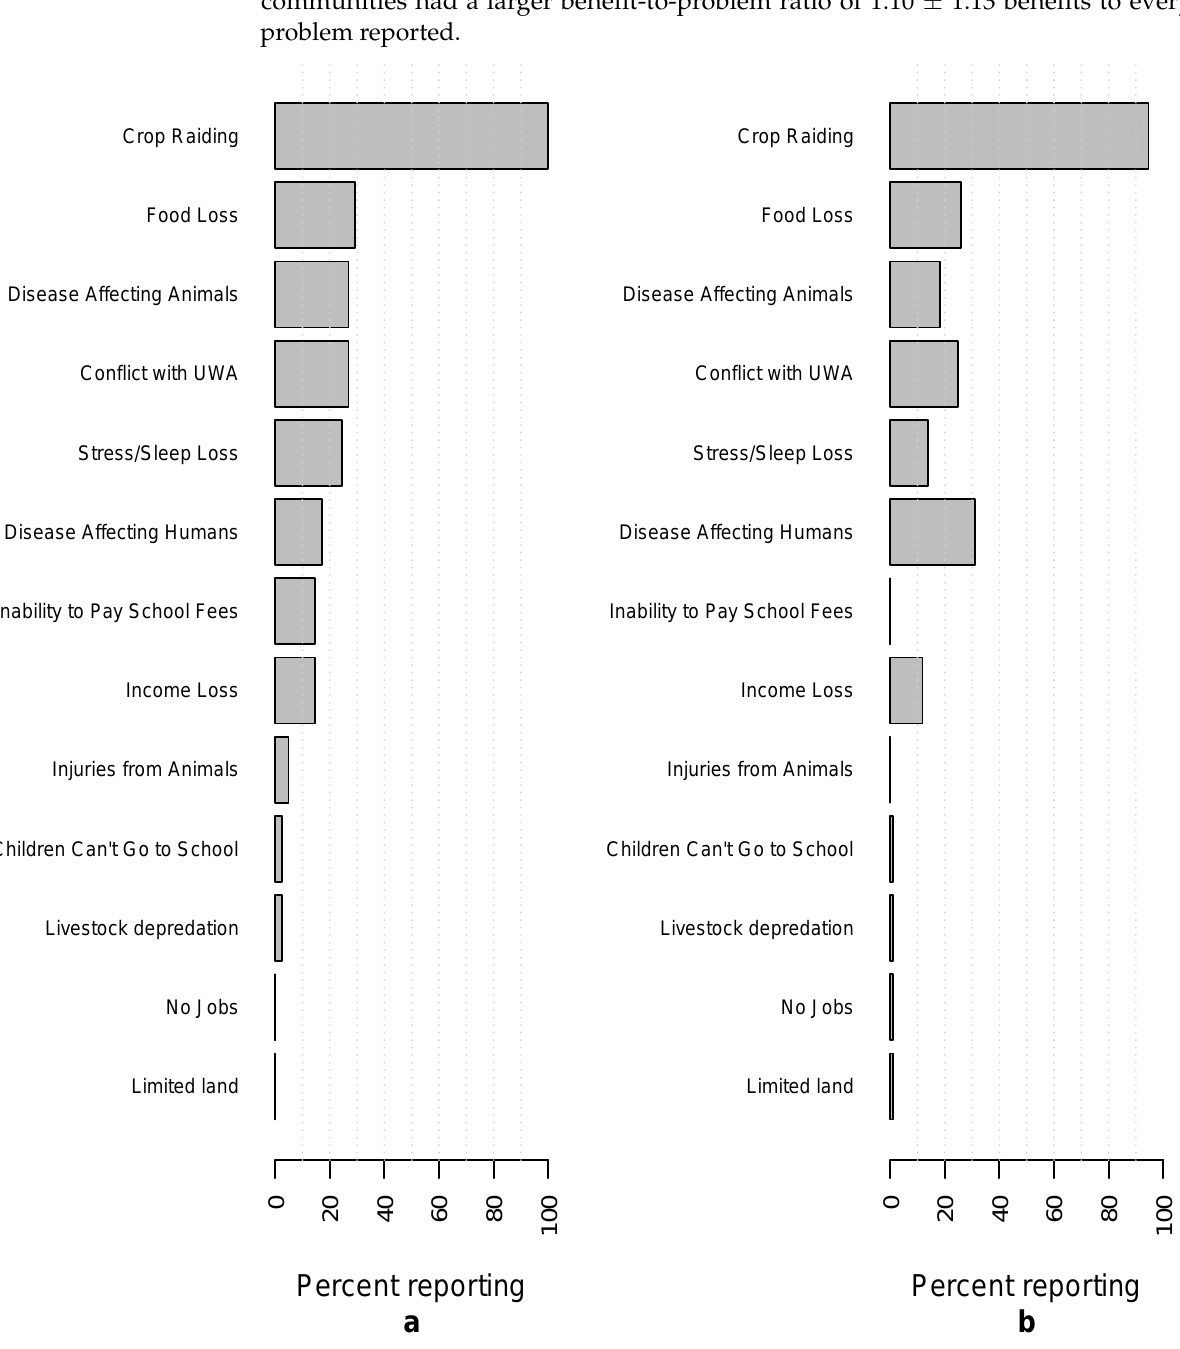
Figure 2. Reported problems of living near KNP according to respondents from ( a ) Community 4 ( n = 41) and ( b ) the participating communities ( n =